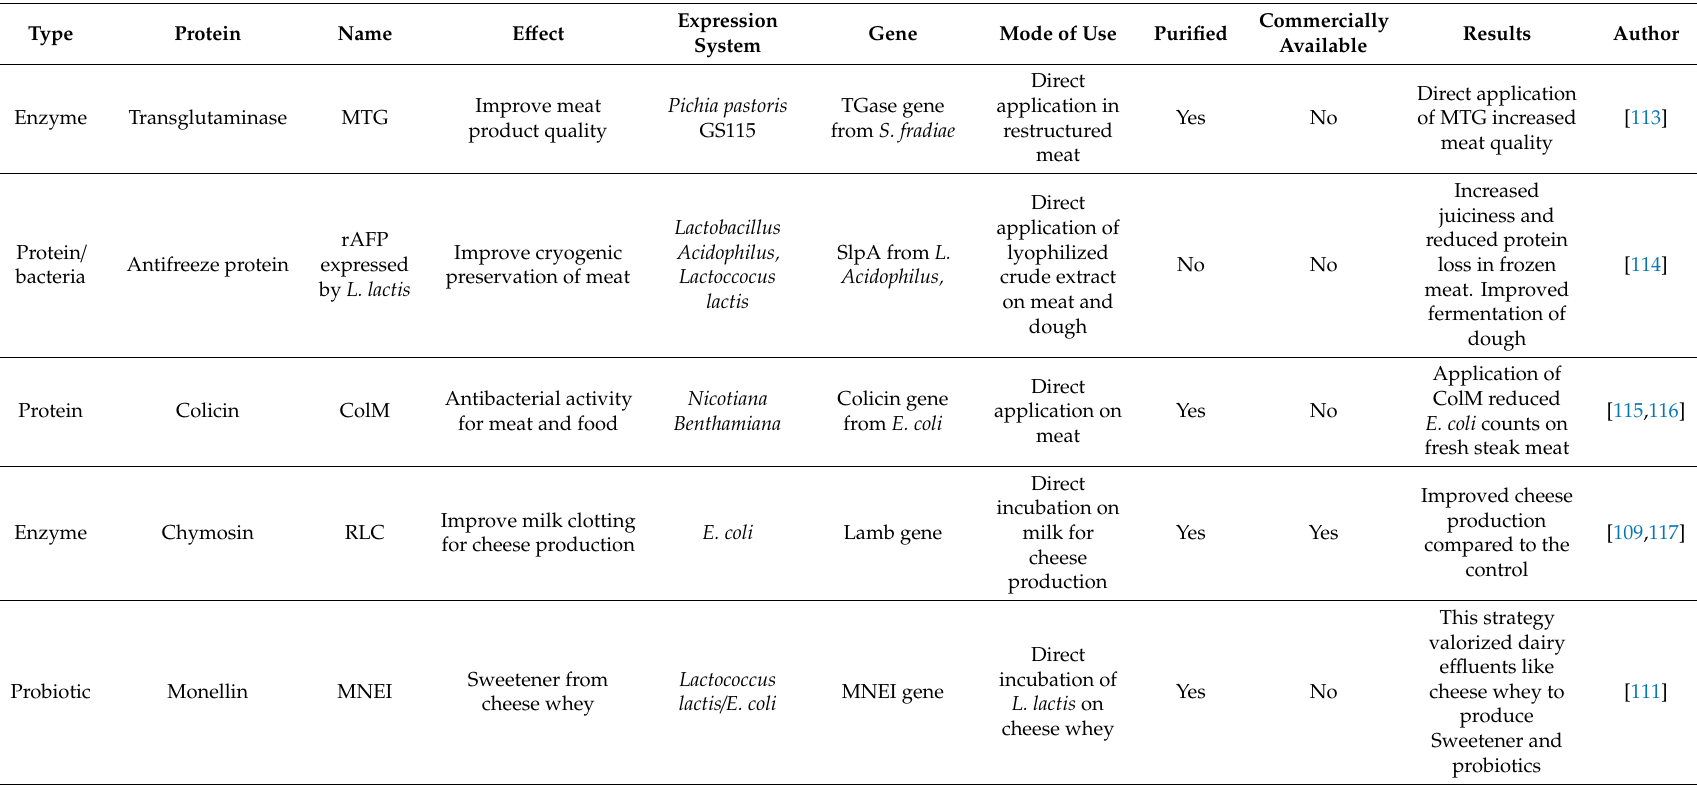
Table 5. Summary of e ff ects of recombinant proteins on processing and sustainability of animal-food